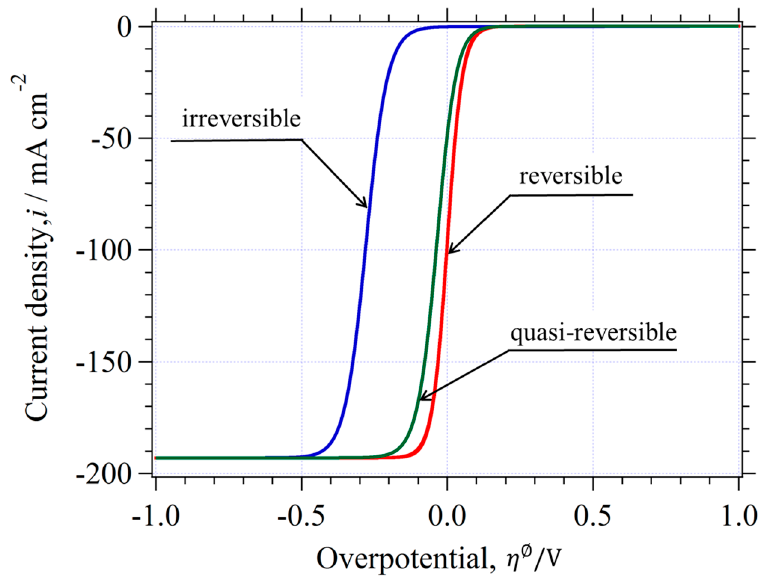
Figure 3. The i − η ∅ curves for the reversible, irreversible, and quasi-reversible reaction are shown. The numerical values used for the drawings are listed in Table 1.